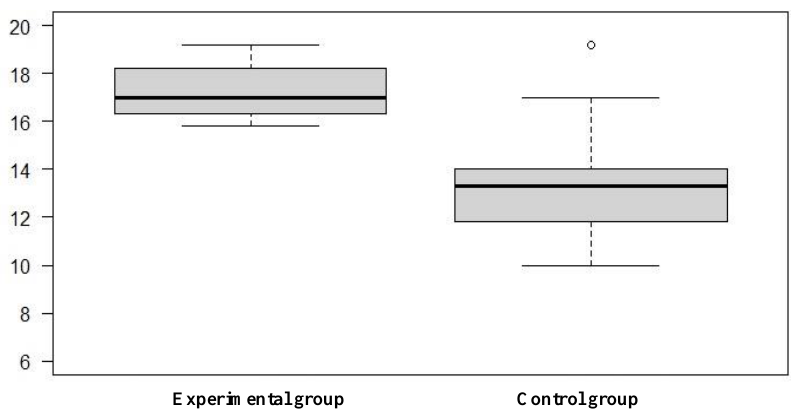
Experimental group Control group Figure 9. Hypothesis 3 – Sum (boxplot)